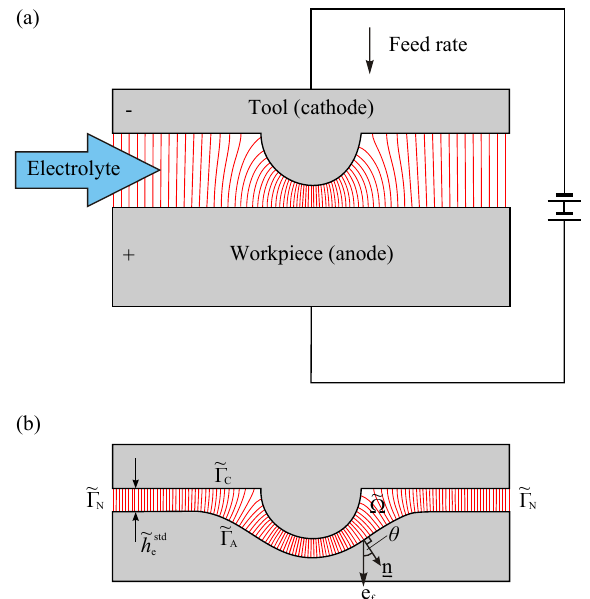
Figure 1. Principle of electrochemical machining (ECM). ( a ) Initial configuration consisting of a cathode tool of a defined shape and a plane anode workpiece to be machined. The tool is advanced towards the workpiece at a defined feed rate. Electrical current flows when a voltage is applied across the gap; the thin red lines between the electrodes illustrate the current density. ( b ) Steady-state configuration of tool and workpiece. The final shape of the workpiece is approximately the negative image of the tool electrode. The inter-electrode gap is the calculation domain ˜ Ω of the model used in this work. The boundaries ˜ Γ C and ˜ Γ A are defined by tool (cathode) and workpiece (anode) surfaces, respectively, and ˜ Γ N is the non-metallic side boundary through which the electrical current flux is zero. For each point on the workpiece boundary ˜ Γ A , θ is defined as the angle between the outer boundary unit normal vector n and the feed direction unit vector e f . “Front gap” refers to an inter-electrode gap region where the workpiece surface is perpendicular to the feed direction (i.e. θ = 0). “Standard front gap” (with steady-state width ˜ h std e ) is a front gap region where the electrodes are plane (figure adapted from Ref.